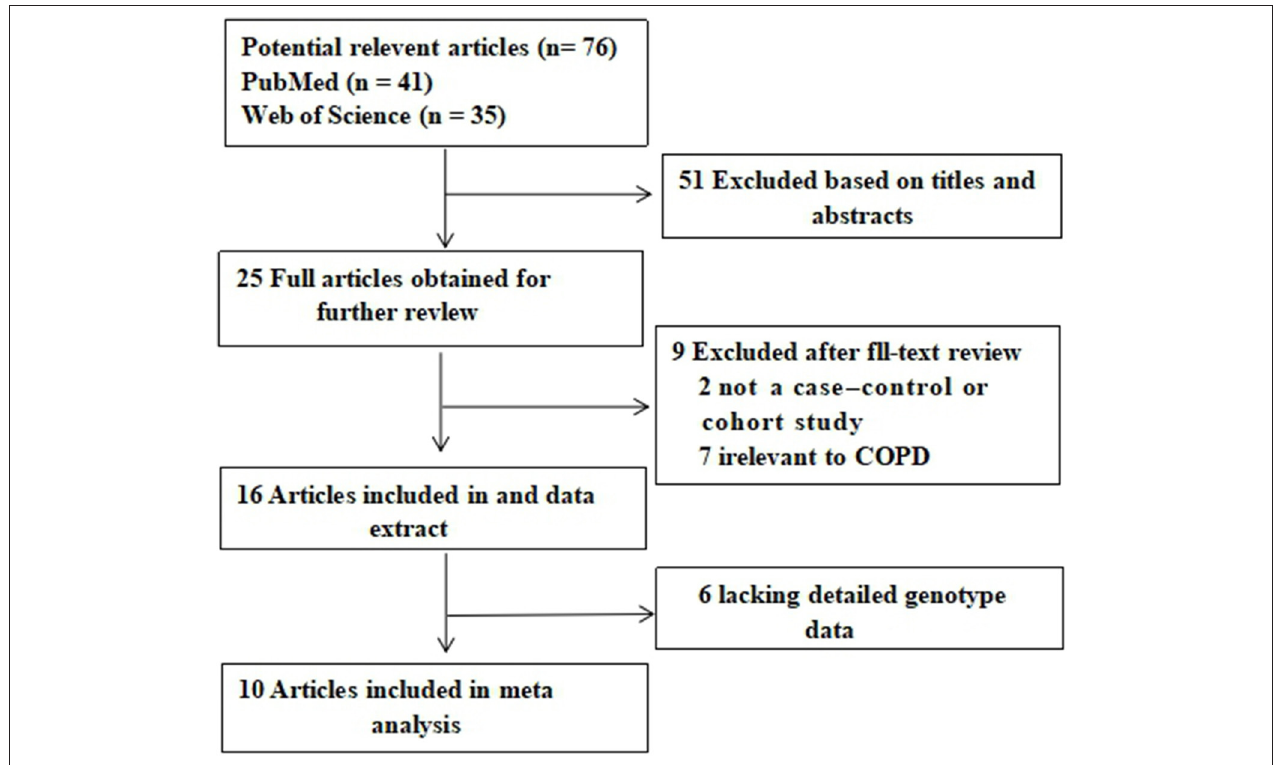
FIGURE 1 | Flow diagram of the literature search and selection.